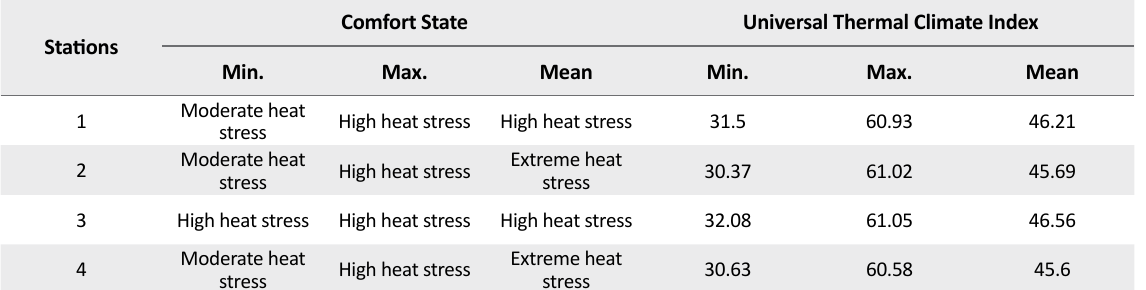
Table 2. UTCI amount in four selected stations